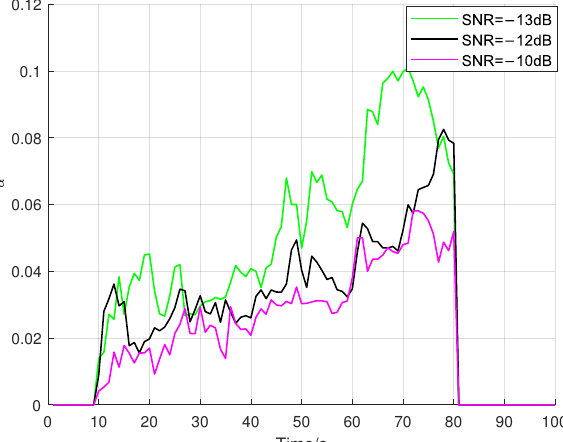
Figure 5. RMSEs of the channel coefficient for the first receiver of the proposed method with different